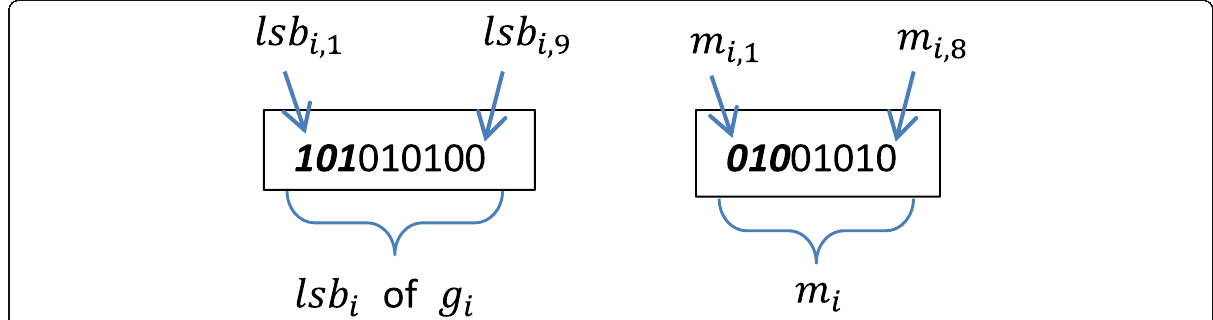
Fig. 4 Illustration for d i ≤ l/2. The length l is 8 and d i is 3. So embedding bits is 01001010 and lsb i,9 will be set to